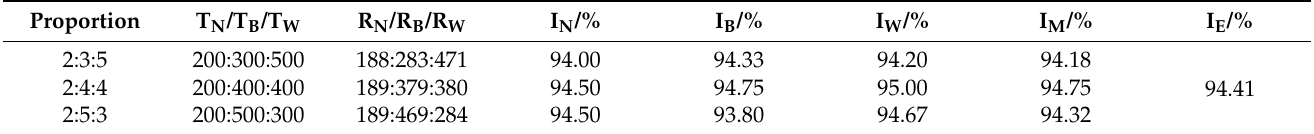
Table 6. The recognition accuracy of the proposed method in this